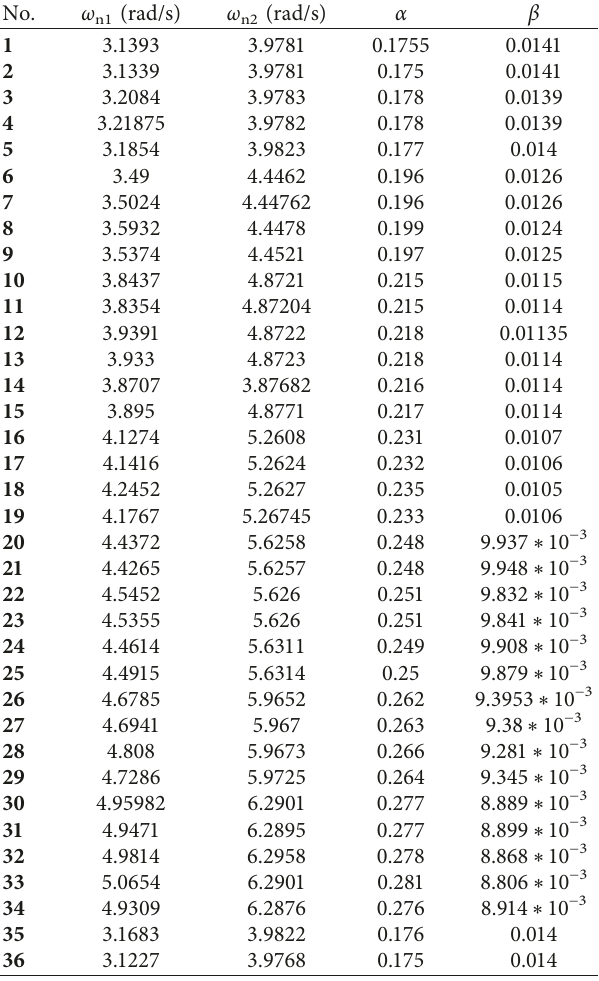
Table 5: The first and second mode frequencies and Rayleigh’s alpha and beta for all models of Table 2 due to modal